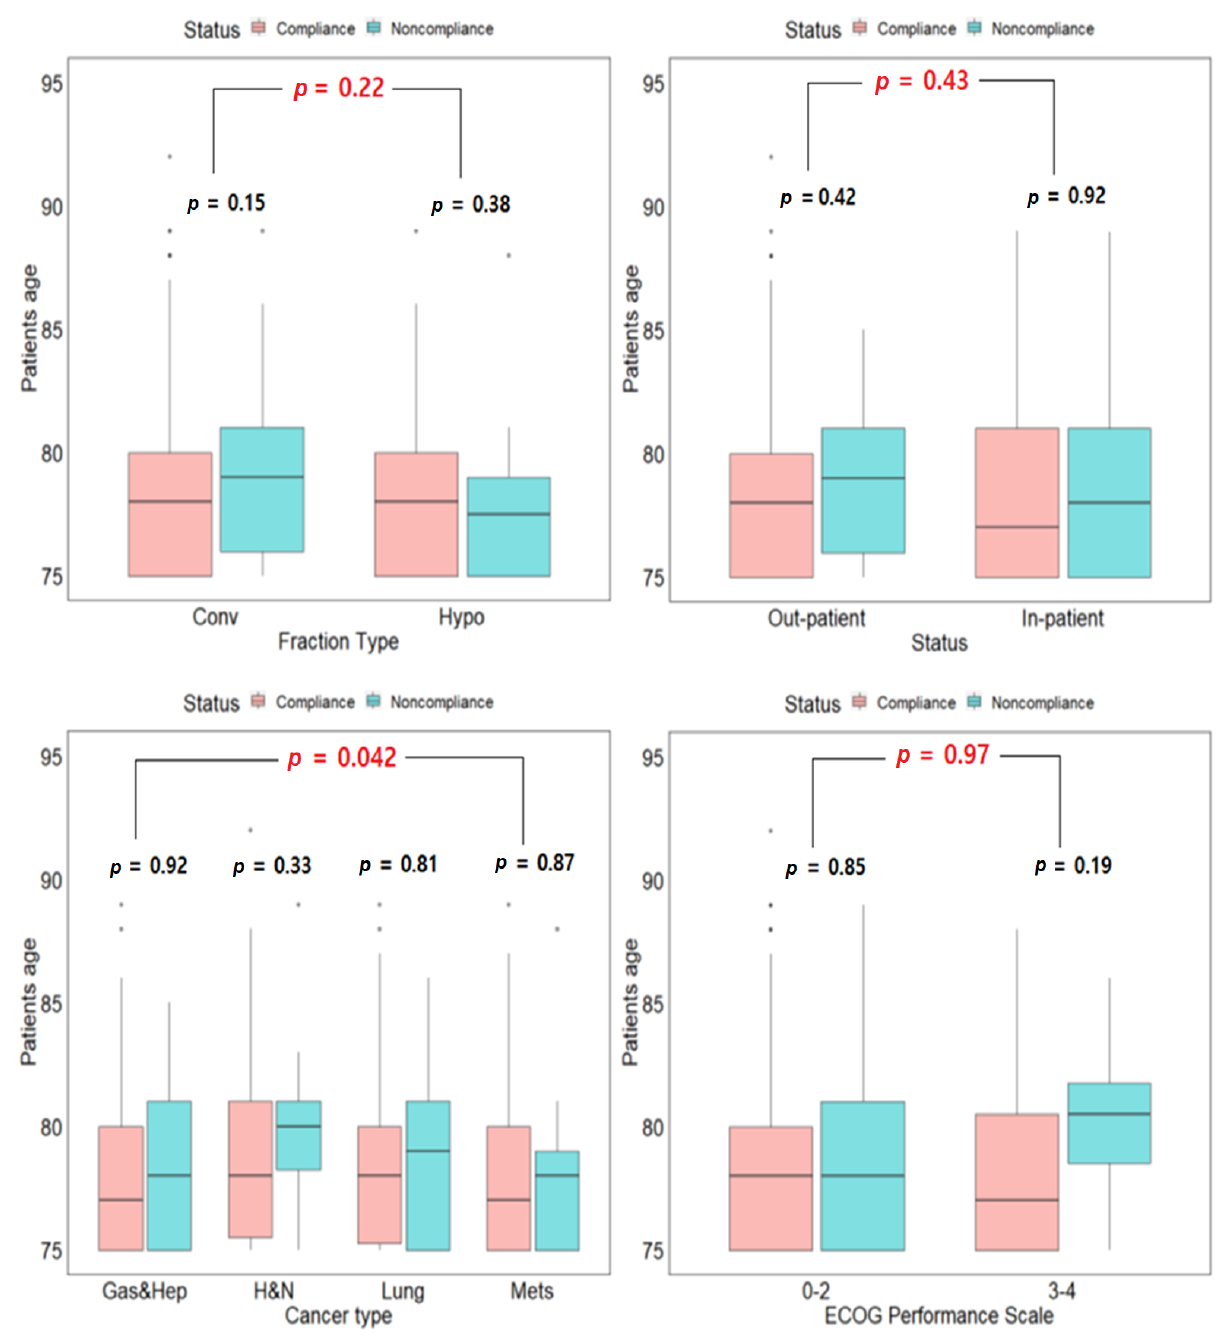
Figure 1. Box-plot of age and all the considered variables by compliance status. p -values in black are for the within-group comparison and red represents the between-group comparison. HI: